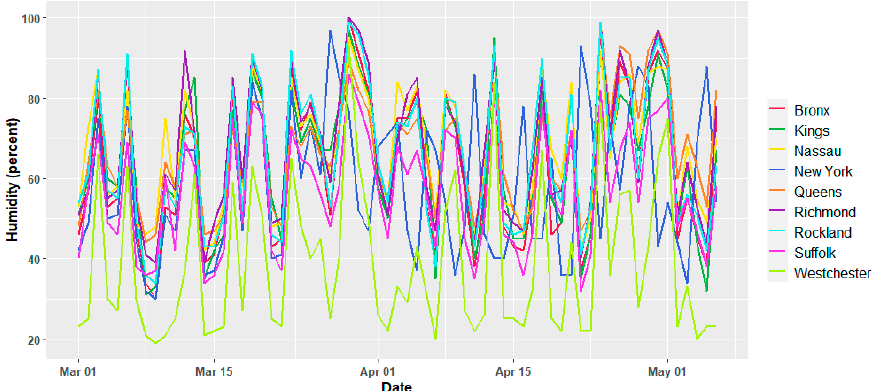
Int. J. Environ. Res. Public Health 2020 , 17 , x Figure A1. Variation of daily average humidity for individual counties. Figure A1. Variation of daily average humidity for individual counties.